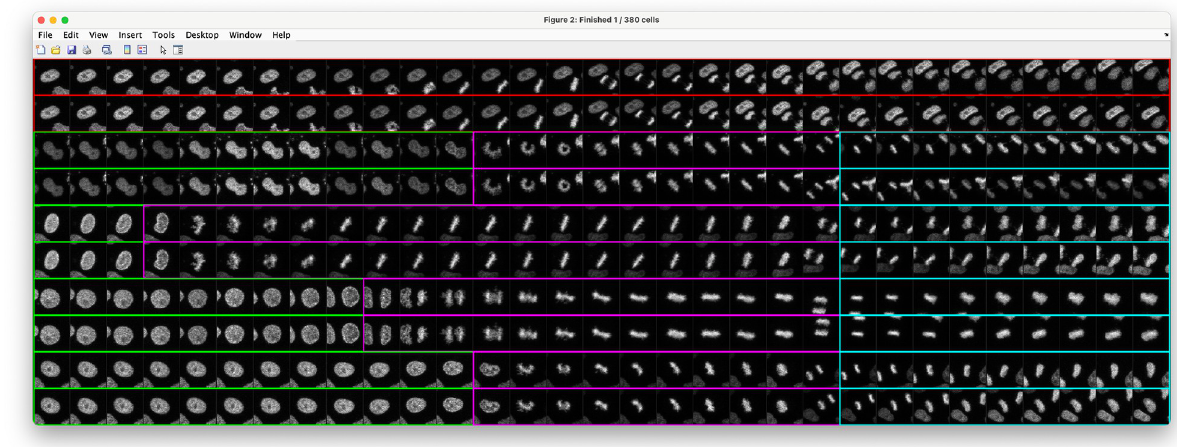
Fig 1. Graphical user interface for trajectory synchronization. Using an intuitive annotation scheme, users can verify and potentially correct the cell synchronization. Moreover, erroneous tracks that do not contain a mitotic event can be discarded. An initial synchronization can be automatically obtained using both classical and machine learning-based synchronization methods as detailed in the main text. Colors indicate interphase frames (green), pro-, prometa-, meta- and early anaphase frames (magenta), late ana- and telophase (cyan) and erroneous trajectories (red).